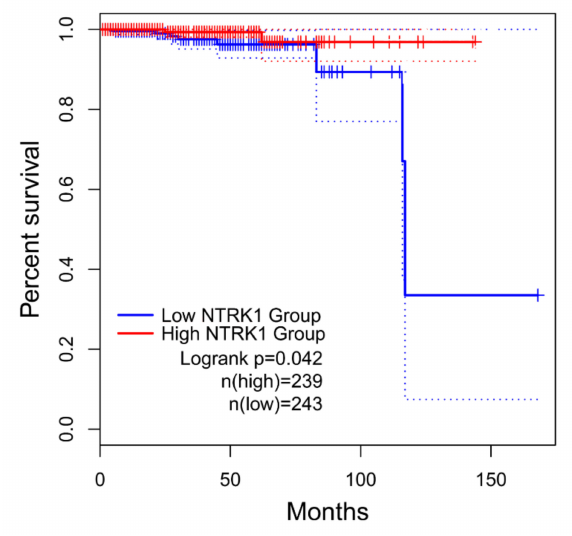
Figure 7. The KM curve was used to estimate OS in PCa patients according to the GEPIA database. The expression of NTRK1 was shown to have a significant impact (log-rank p -value < 0.05) on the PCa prognosis using KM estimates (log-rank test). The solid line shows the survival curve, and the dotted line represents the 95% CI. Patients with expression levels above the median are shown with red lines, while those with levels below the median are marked with blue lines. GEPIA, gene expression profiling interactive analysis. OS, overall survival; KM, Kaplan–Meier; PCa, prostate cancer; and CI, confidence